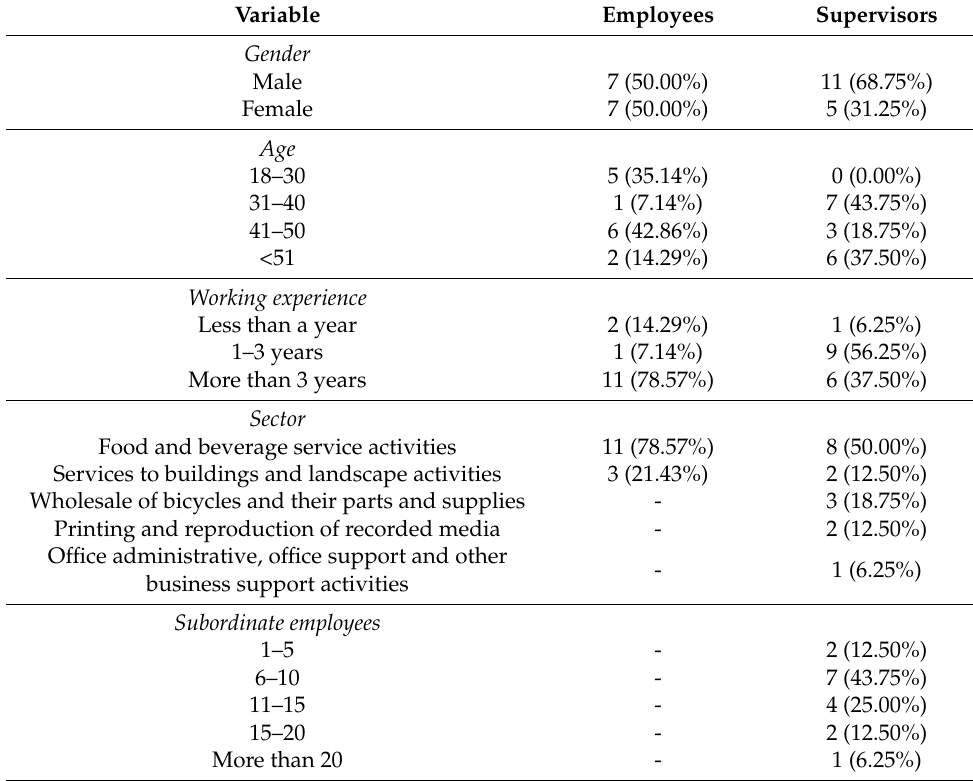
Table 2. Participant characteristics of social firms’ employees and supervisors in percent.